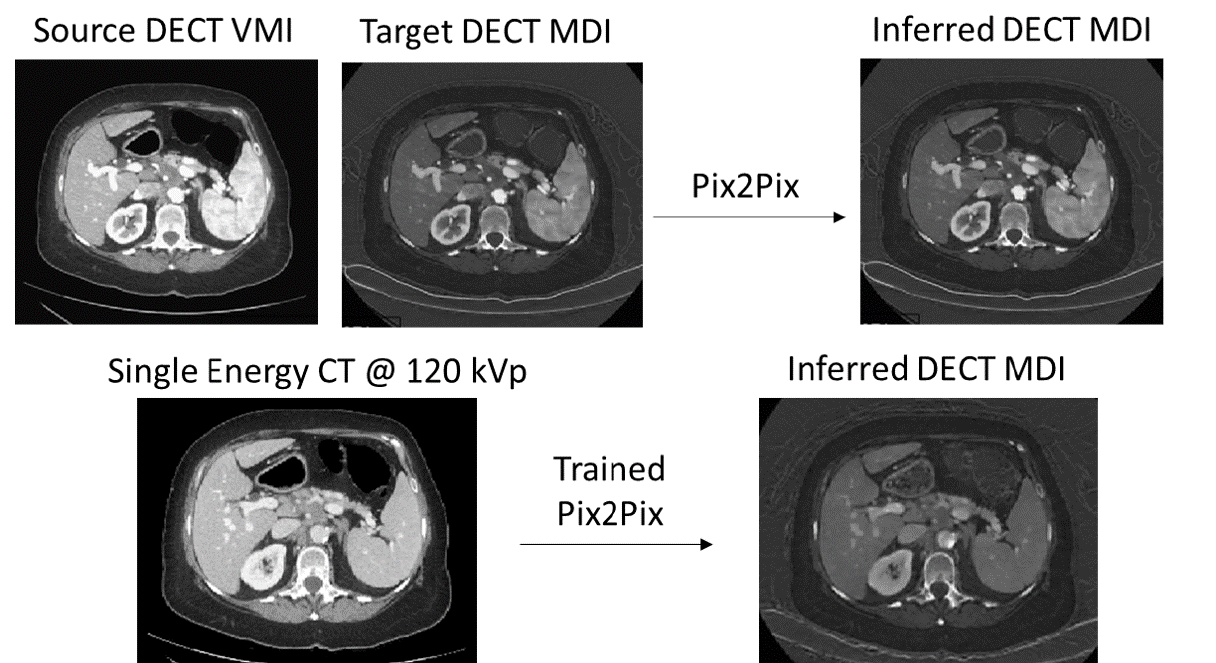
Figure 1. The Pix2Pix system was trained to map dual-energy CT virtual monochromatic images (DECT VMI) reconstructed at 70 keV to DECT material density iodine (MDI) images. Then, the trained system is used to convert single energy CT (SECT) scans acquired at 120 kVp to the synth-DECT MDI image types. Four liver segmentation frameworks were trained and tested with synth-DECT MDI and SECT